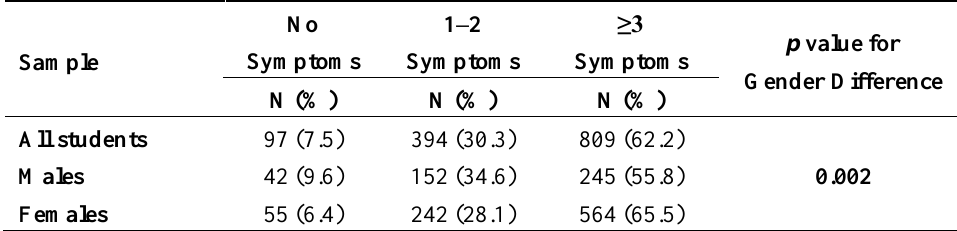
Table 3. Number of symptoms reported in last 12 months.